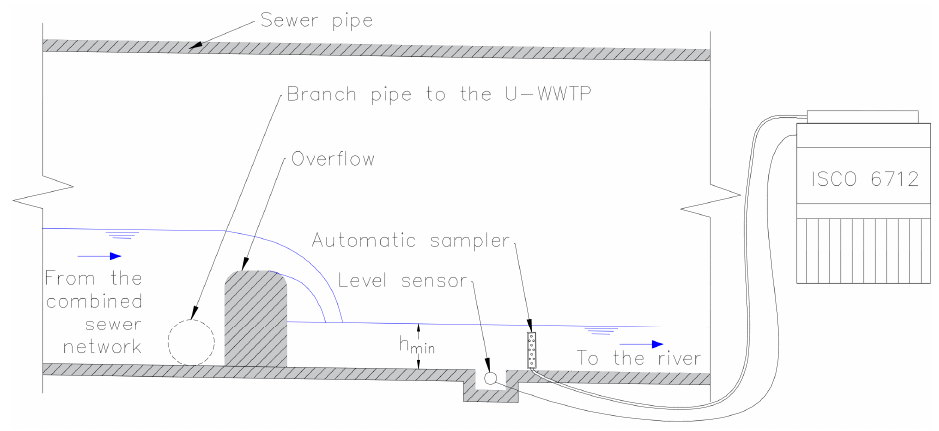
Figure 2. Automatic data recording scheme in the pipe section near the discharge.